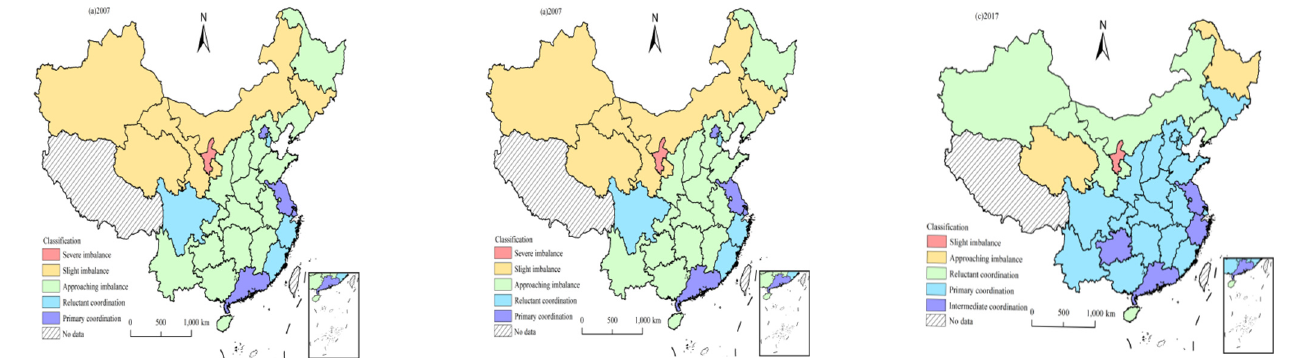
Figure 5. The spatial distribution of the coupling coordination degree of 30